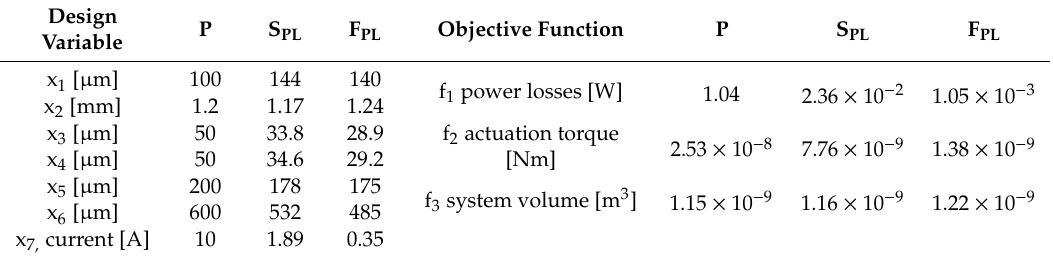
Table 3. Values of the design variables and objective functions for points P, S PL and F PL (Figures 9–11).